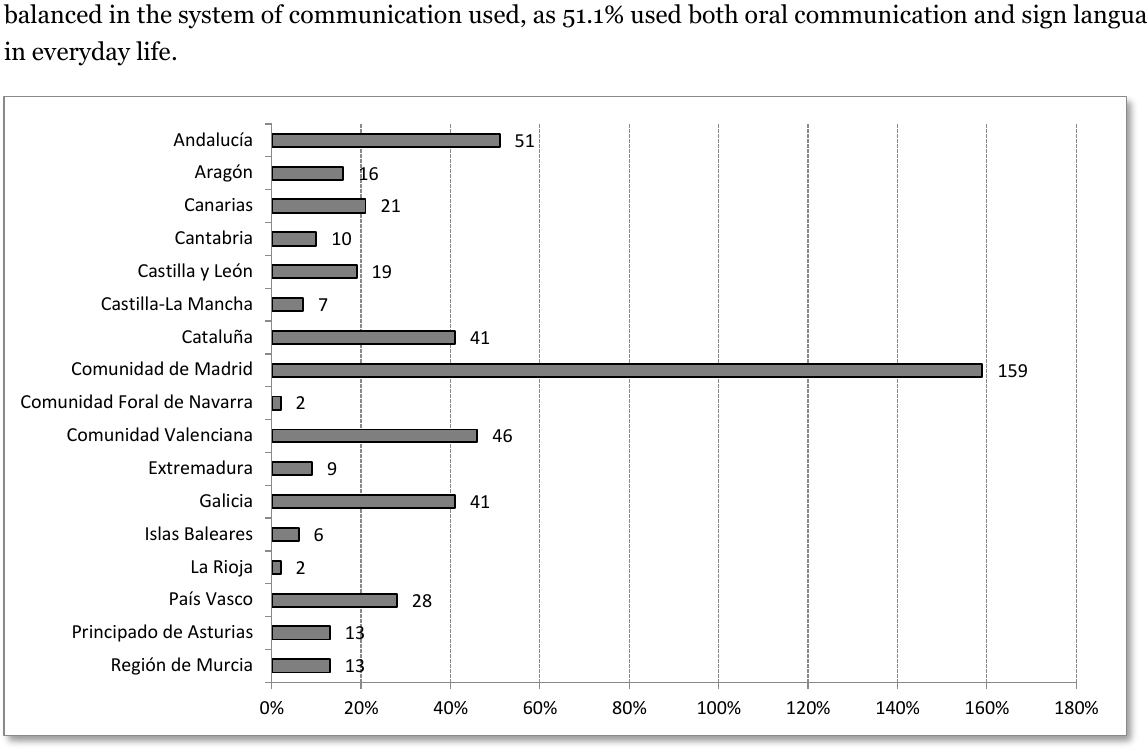
Figure 3. Breakdown of sample by Autonomous Regions (absolute numbers). The regions considered are Spain's first level administrative division, consisting of 17 "Autonomous Communities" with a certain number of transferred